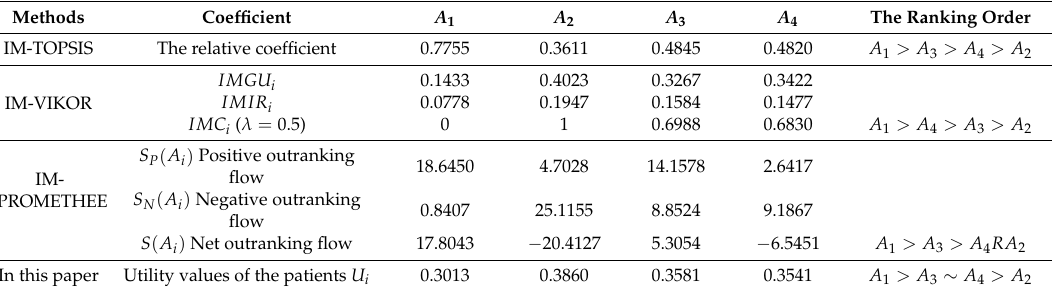
Table 9. Comparison between our proposed method and the existing methods.